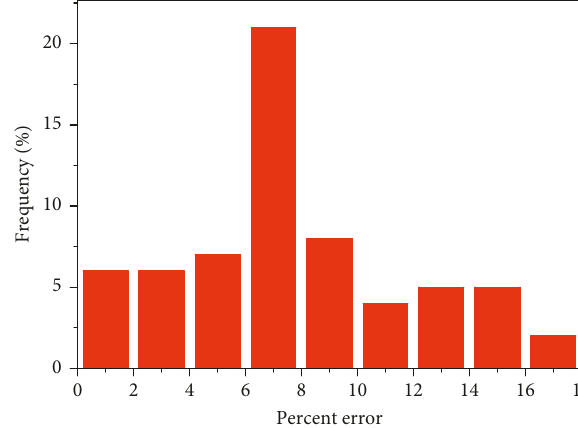
Figure 8: The frequency distribution of percent errors on daily ET estimates obtained by the Gaussian fitting method. Table 5: Estimation errors at the site of EC1 EC4, EC10, and